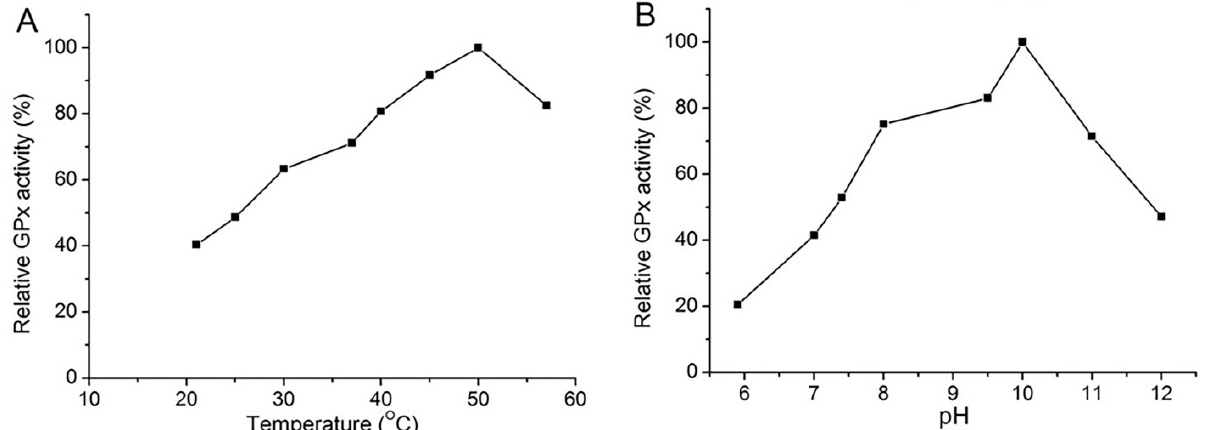
Figure 7. Effects of ( A ) temperature and ( B ) PH on the activity of Sec − hGPx3 − C8/132U: Activity was determined with the concentrations of GSH and t − BuOOH at 1 mM and 0.3 mM, respectively. ( A ) Plot of GPx activity versus temperature; the highest activity at 50 °C was set as 100%; ( B ) Plot of GPx activity versus pH; the highest activity at pH 10 was set as 100%.